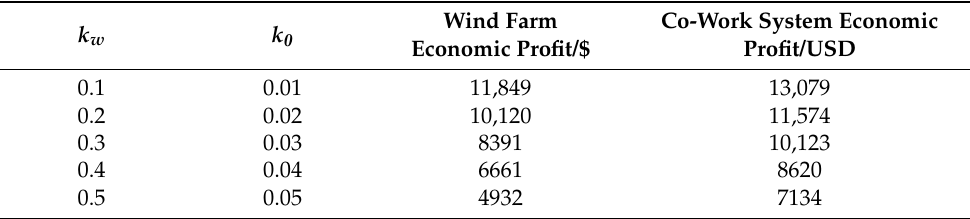
Table 4. Economic benefits of the wind farm with different levels of forecast.